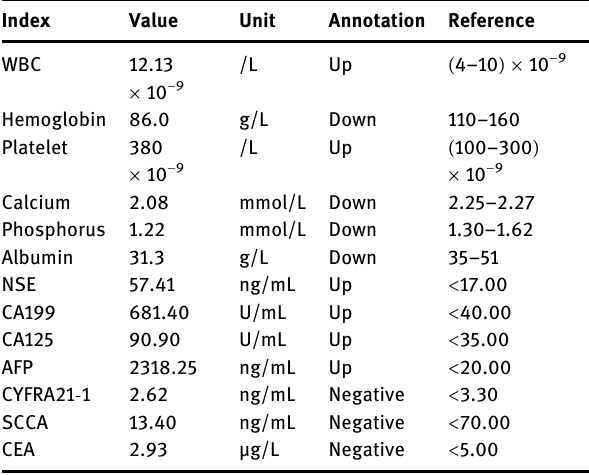
Table 1: Laboratory examination and tumor marker test results